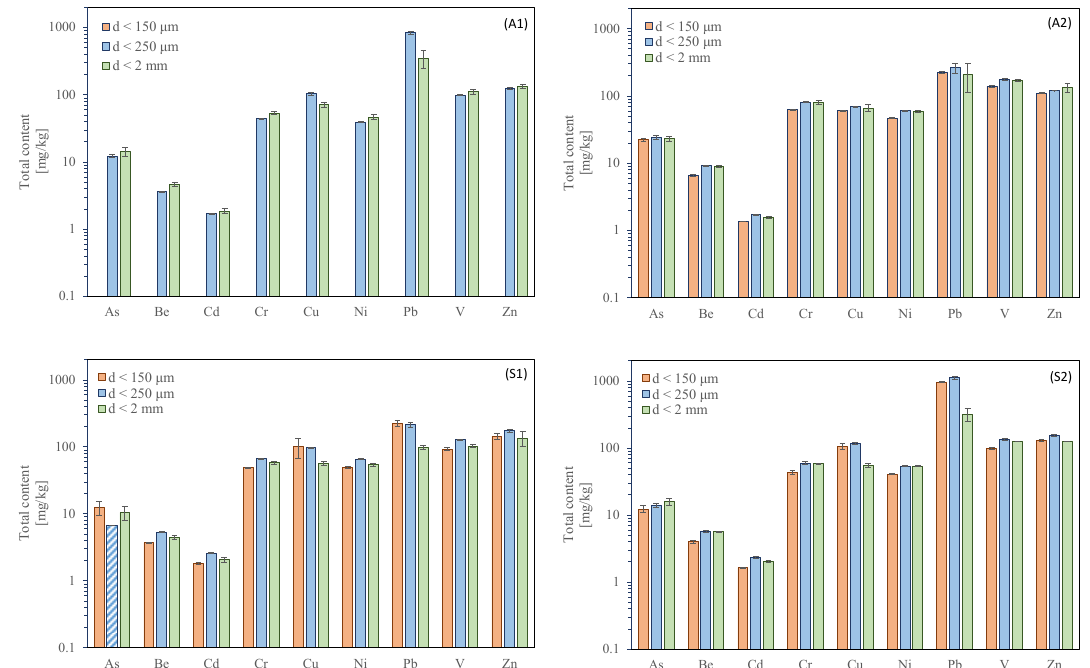
Figure 1. Total inorganic content of fraction d < 2 mm, d < 250 µ m, and d < 150 µ m for samples A1 , A2 , S1 , and S2 (striped bars represent values below the limit of quantification).